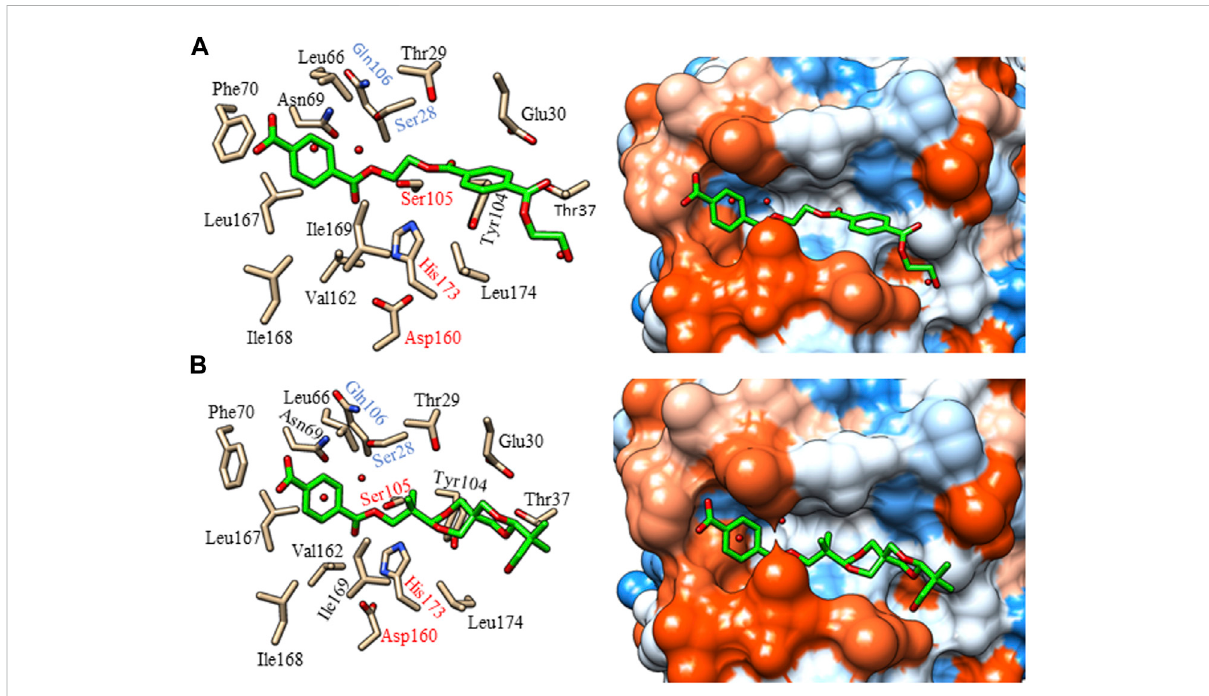
FIGURE 8 Molecular docking of HiCut with hydrolyzable and non-hydrolyzable ligands (in green). (A) Complexes HiCut/(MHET) 2 and (B) HiCut/TPA- spiroglycol. On the right, amino acids surround the ligands. Catalytic amino acids are labeled in red, and the suggested amino acids for the oxyanion holeareinblue.Ontheleft, therepresentationofthehydrophobicity surfaces isaccordingto theKyte-Doolittlescale,which isfrom dodgerbluefor the most hydrophilic to white and orange-red for the most hydrophobic (Kyte and Doolittle,